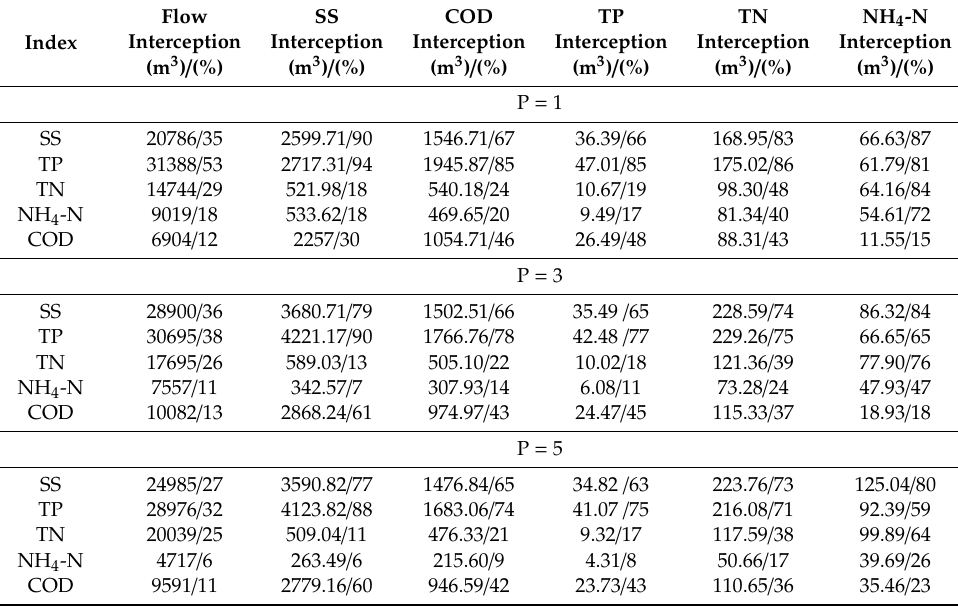
Table 8. The control simulation of various water quality